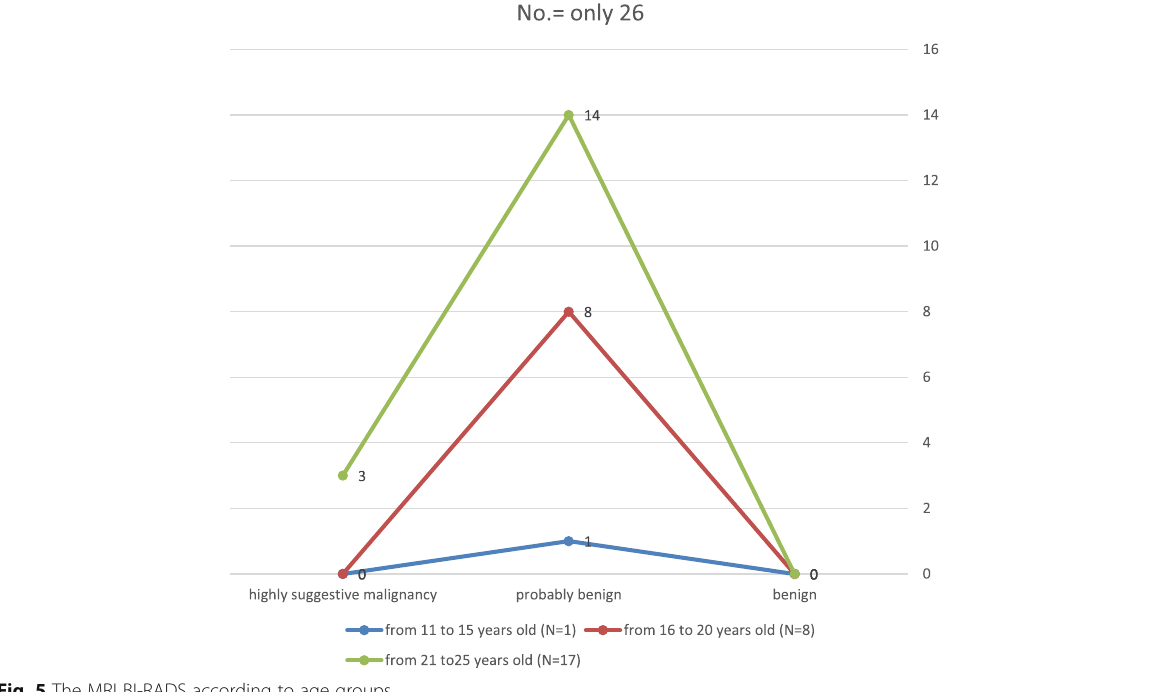
Fig. 5 The MRI BI-RADS according to age